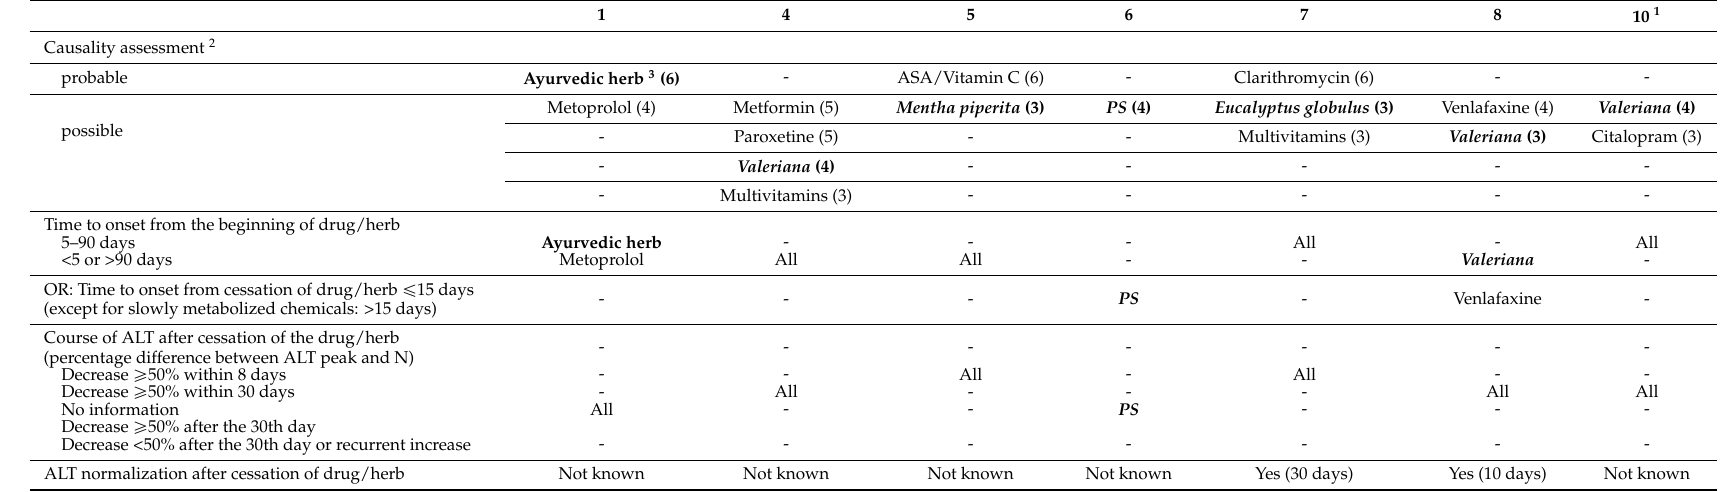
Table 3. Data on drug or herb intake of the patients with herb-induced liver injury and hepatocellular